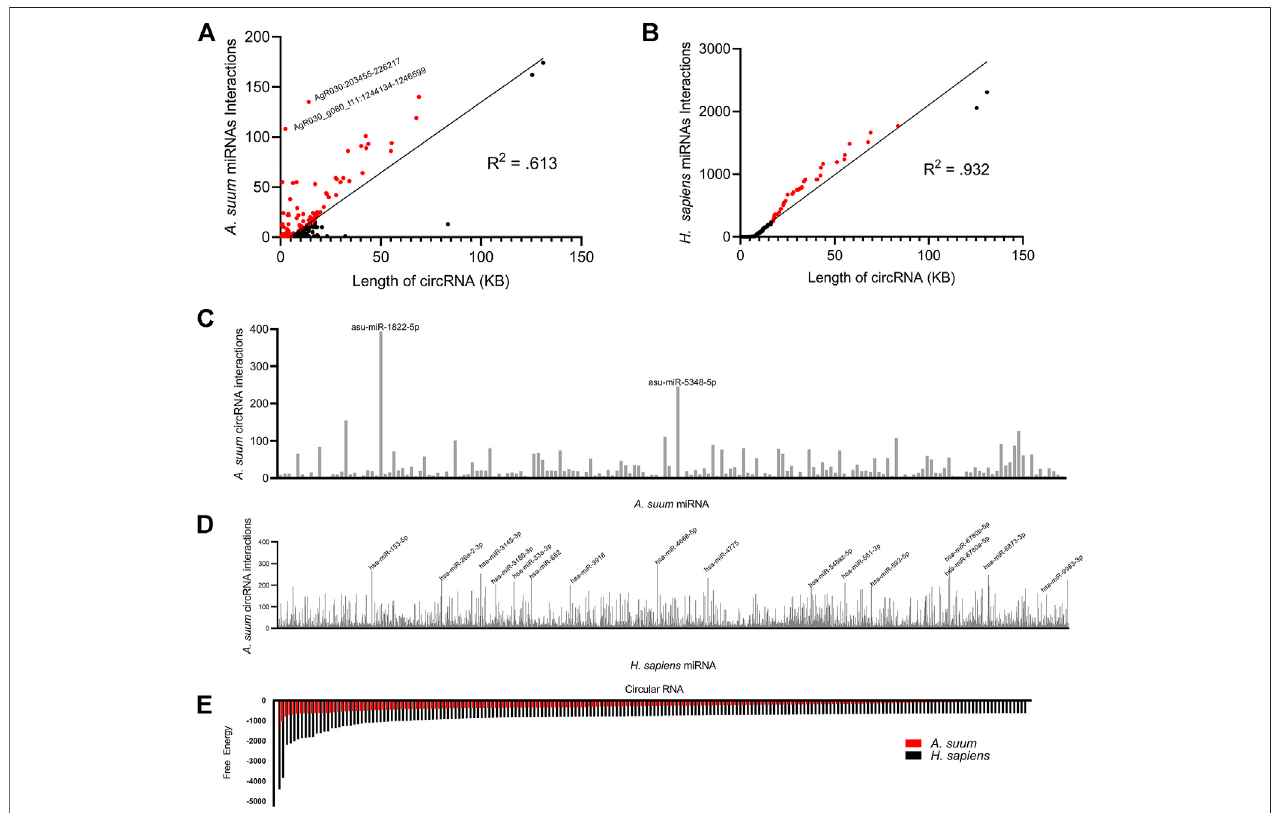
FIGURE 8 | A pro fi le of Ascaris suum circRNA-miRNA interactions. miRanda was used to predict Ascaris circRNA interactions with both endogenous Ascaris miRNAsandhumanhostmiRNAs.Thenumberof Ascaris miRNAinteractions (A) andhumanmiRNAinteractions (B) wasplottedagainstindividualcircRNAlengthusing a line of best fi t. A less strong correlation between circRNA length and Ascaris miRNA interaction suggests Ascaris circRNAs are enriched for Ascaris miRNA binding sites. CircRNAs enriched formiRNA binding sitesrelativetotheir lengtharehighlightedinred.The frequencyofbinding eventsforindividual Ascaris (C) andhuman (D) miRNAs at Ascaris circRNAs was plotted. Only miRNAs with 10 or more interactions were included. Highlighted individual miRNAs had over 200 interactions with Ascaris circRNAs. (E) The miRanda free energy score was used to assess Ascaris circRNA-miRNA binding strength. Lower miRanda free energy scores are associated with a more thermodynamically stable bond between circRNA and miRNA. miRanda scores suggest Ascaris cirRNA- Ascaris miRNA interactions (red) are weaker than Ascaris cirRNA-human miRNA interactions. Only the lowest 200 free energy scores are included.